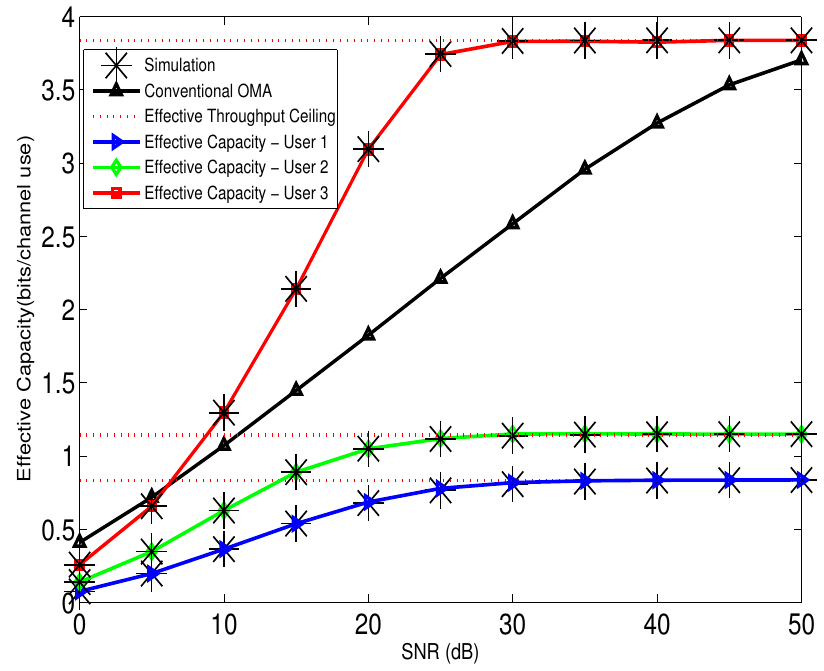
Figure 2. Effective capacity vs. the transmit SNR, with n = 300, θ 1 = θ 2 = θ 3 = 0.01, and ε = 10 − 5